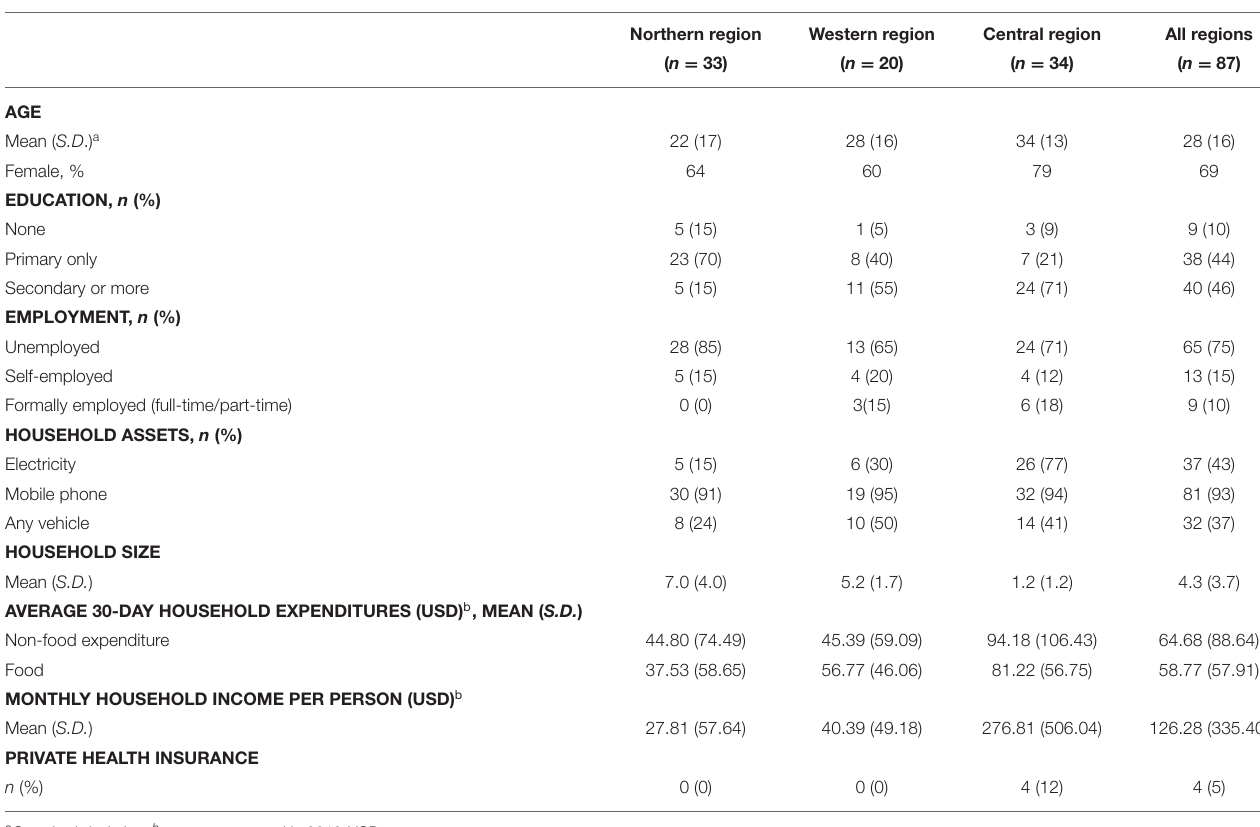
TABLE 1 | Baseline characteristics of sampled participants.